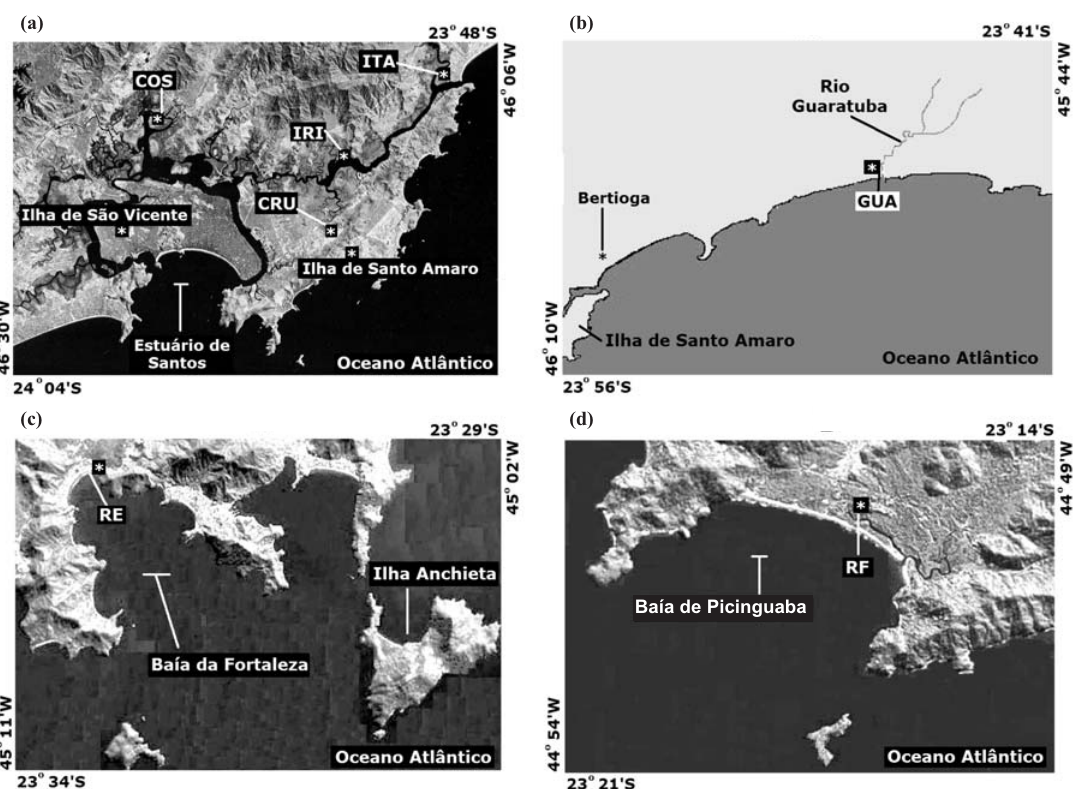
Figura 6. Localização dos manguezais da Baixada Santista e Litoral Norte. (a) manguezais dentro do estuário de Santos; (b) manguezal de Guaratuba; (c) manguezal do Rio Escuro; e (d) manguezal do Rio da